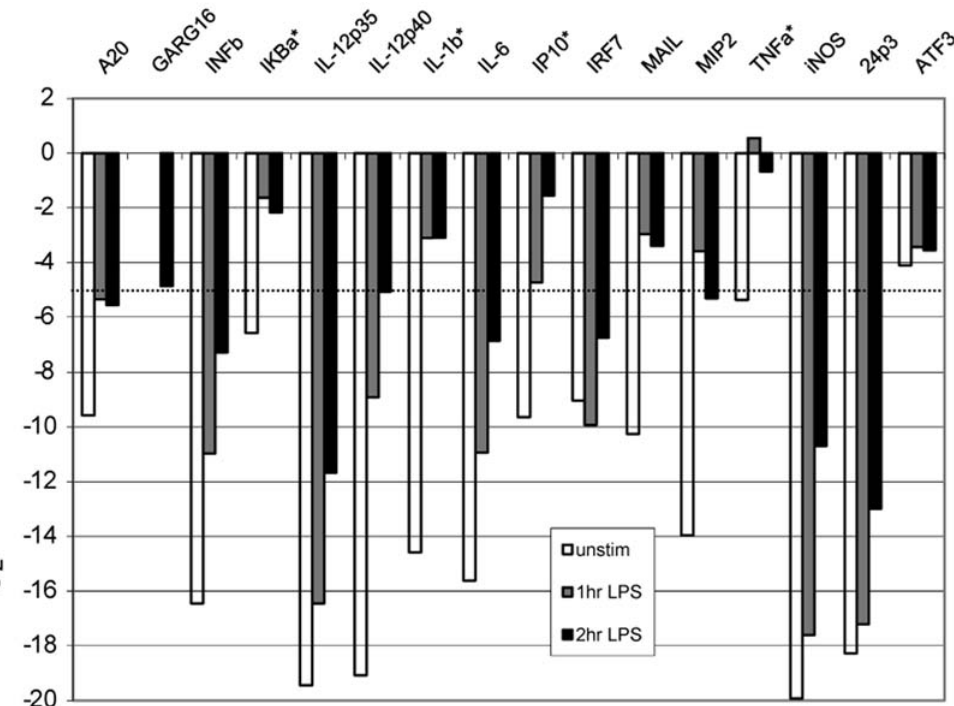
Figure 4. Relative abundance of immune genes in resting and activated macrophages. cDNA synthesis was performed from resting (open bar) and LPS-stimulated (1 hr, grey bar, or 2 hour, black bar) bone marrow macrophages (2.1 6 10 6 cells). The indicated genes were detected by real- time PCR and their abundance (C t , mean of duplicates) is plotted relative to the EF1 a signal ( EF1 a C t : Unstimulated=18.54; LPS 1 Hour=18.19; LPS 2 hours=18.76). We estimate that we are able to detect gene expression within a C t of 5 of EF1 a signal (dotted line). An asterisk indicates the genes that were further investigated in single cells in the experiment shown in Figure 5.